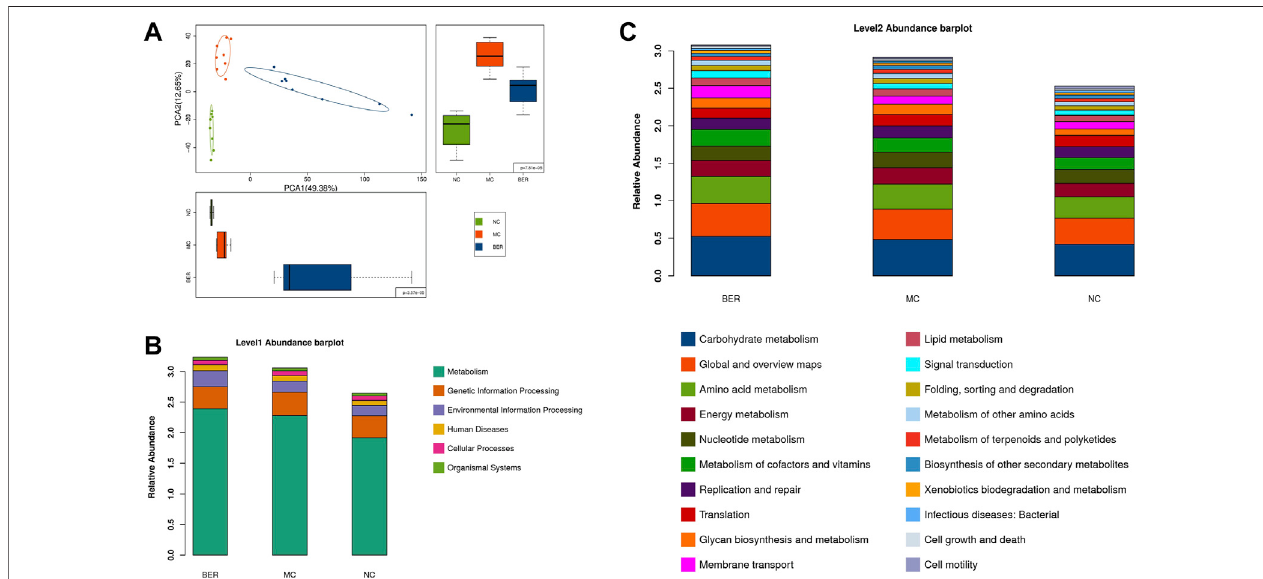
FIGURE 5 | Metabolomic characteristics of the NC group, MC group and BER group. (A,B,C) Boxplot of differential metabolites.